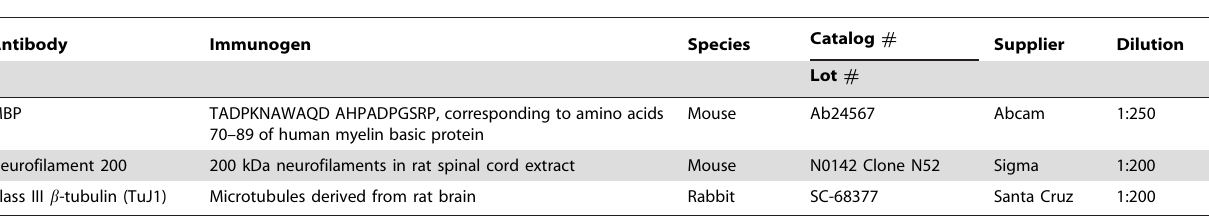
Table 2. Antibody